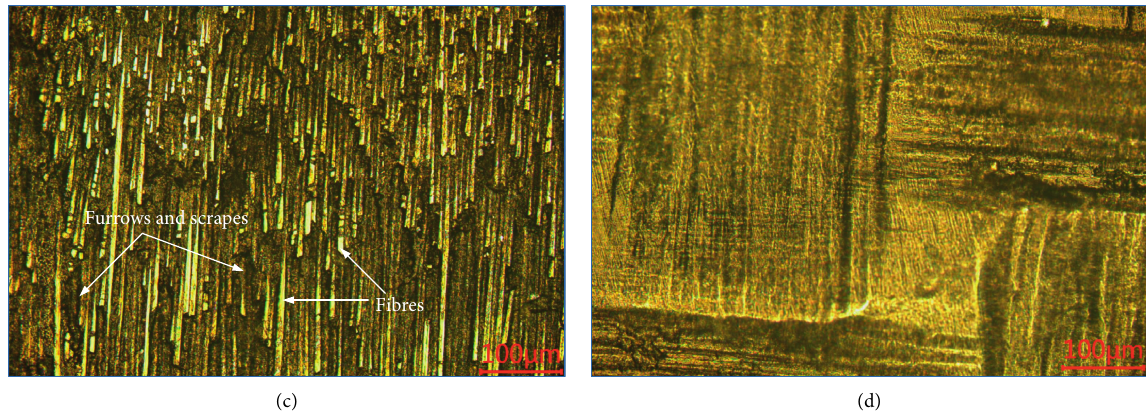
Figure 10: Microscopic morphologies of composite T300/BS-4 paired with brass pin under (a) 50N, (b) 75N, and (c) 100N loads and (d) before the test.